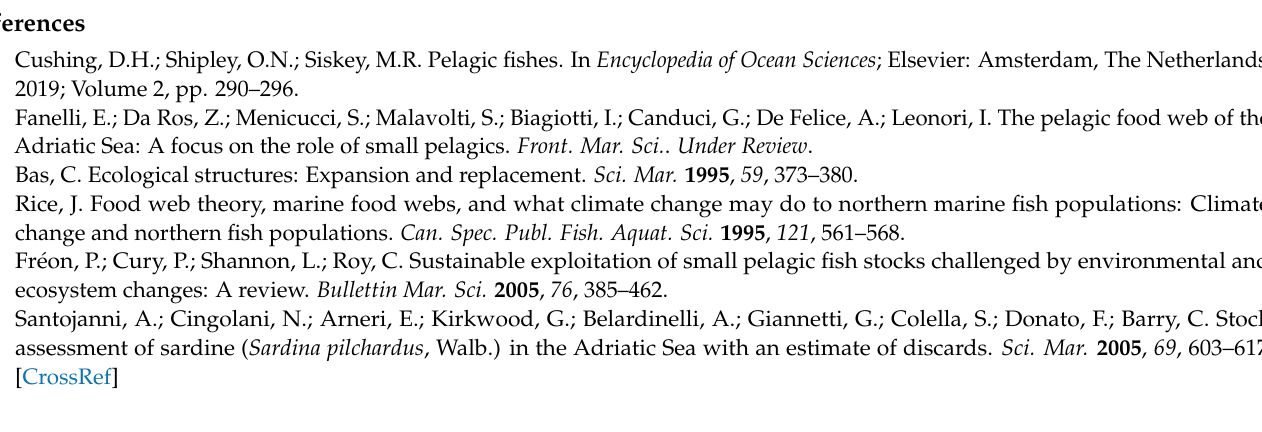
lary” species. Table S4: List of %W, %N, %F and %IRI values of stomach contents found in Scomber colias , in North, Central and South Adriatic Sea. Table S5: Results of multivariate PERMANOVA main test carried out on the diet composition (%W) of each one of the four pelagic “ancillary” species. Table S6: Output of SIMPER analysis conducted on the diet composition (%W) of S. colias within each area. Table S7: Results of multivariate PERMANOVA main test carried out on the diet diver- sity (H’) of the four pelagic “ancillary” species. Table S8: List of %W, %N, %F and %IRI values of stomach contents found in Scomber scombrus , in North, Central and South Adriatic Sea. Table S9: Output of SIMPER analysis conducted on the diet composition (%W) of S. scombrus within each area. Table S10: List of %W, %N, %F and %IRI values of stomach contents found in Trachurus mediterraneus , in North, Central and South Adriatic Sea. Table S11: Output of SIMPER analysis conducted on the diet composition (%W) of T. mediterraneus within each area. Table S12: List of %W, %N, %F and %IRI values of stomach contents found in Trachurus trachurus , in North, Central and South Adriatic Sea. Table S13: Output of SIMPER analysis conducted on the diet composition (%W) of T. trachurus within each area. Table S14: Output of SIMPER analysis conducted on the diet composition (%W) of all the four pelagic “ancillary” species. Table S15: Output of PERMDISP multivariate dispersion test conducted on values of the diet composition (%W) of the four pelagic “ancillary” species. Table S16: Mean values of δ 13 C corrected (‰) and δ 15 N (‰) measured in the specimens belonging to the four “ancillary” species. Table S17: Results of univariate PERMANOVA main and pairwise tests carried out on the δ 13 C, δ 15 N and C:N values of the four pelagic “ancillary”